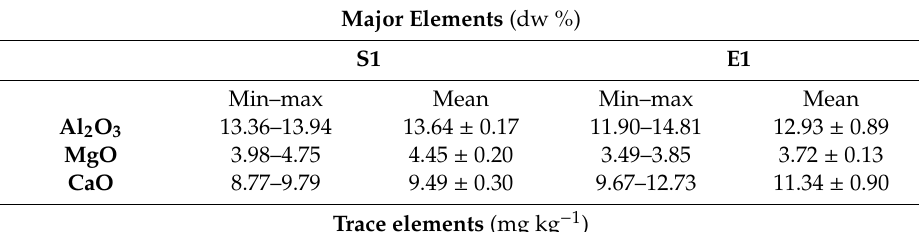
Table 3. Geochemical analyses of S1 and E1 sediment cores (ANOC ‐ 16).